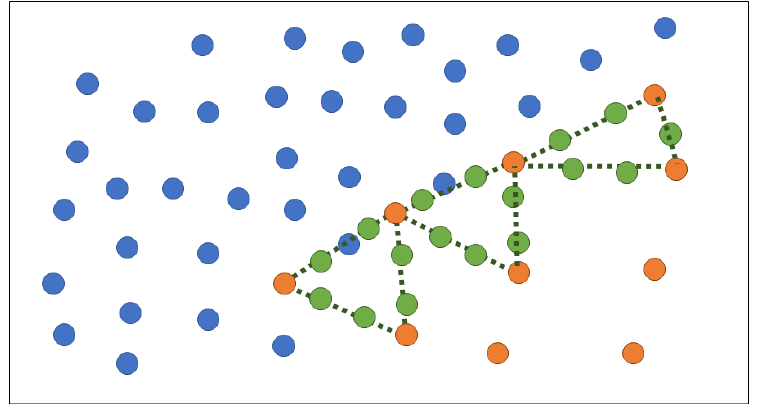
Figure 6. Borderline-SMOTE processing. Blue indicates the majority dataset (non-respiratory failure). Orange indicates the minority dataset (respiratory failure). Green indicates the minority dataset (respiratory failure) generated by Borderline-SMOTE.